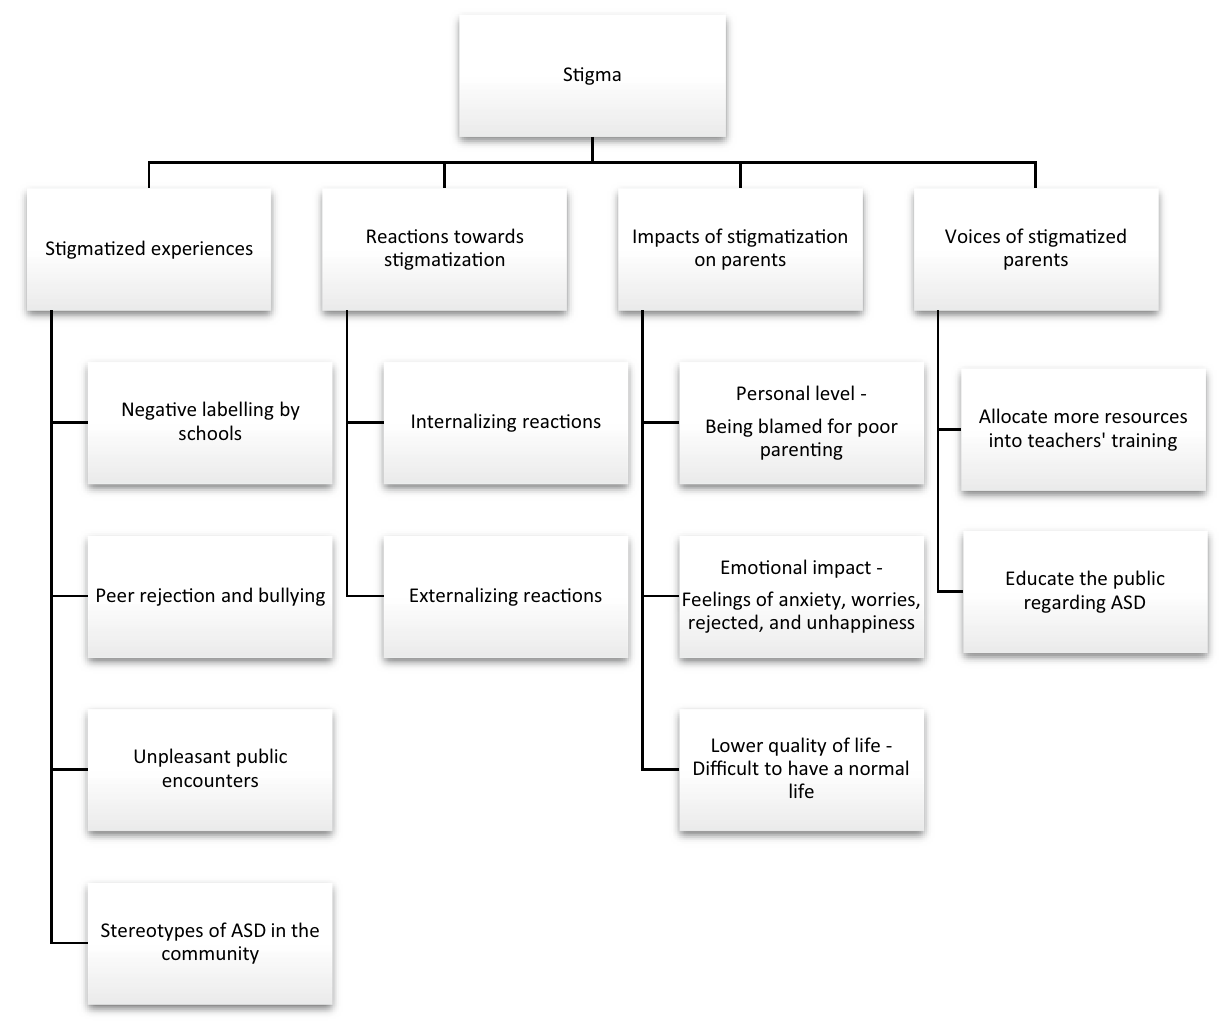
Figure 1. Themes and subthemes of individual